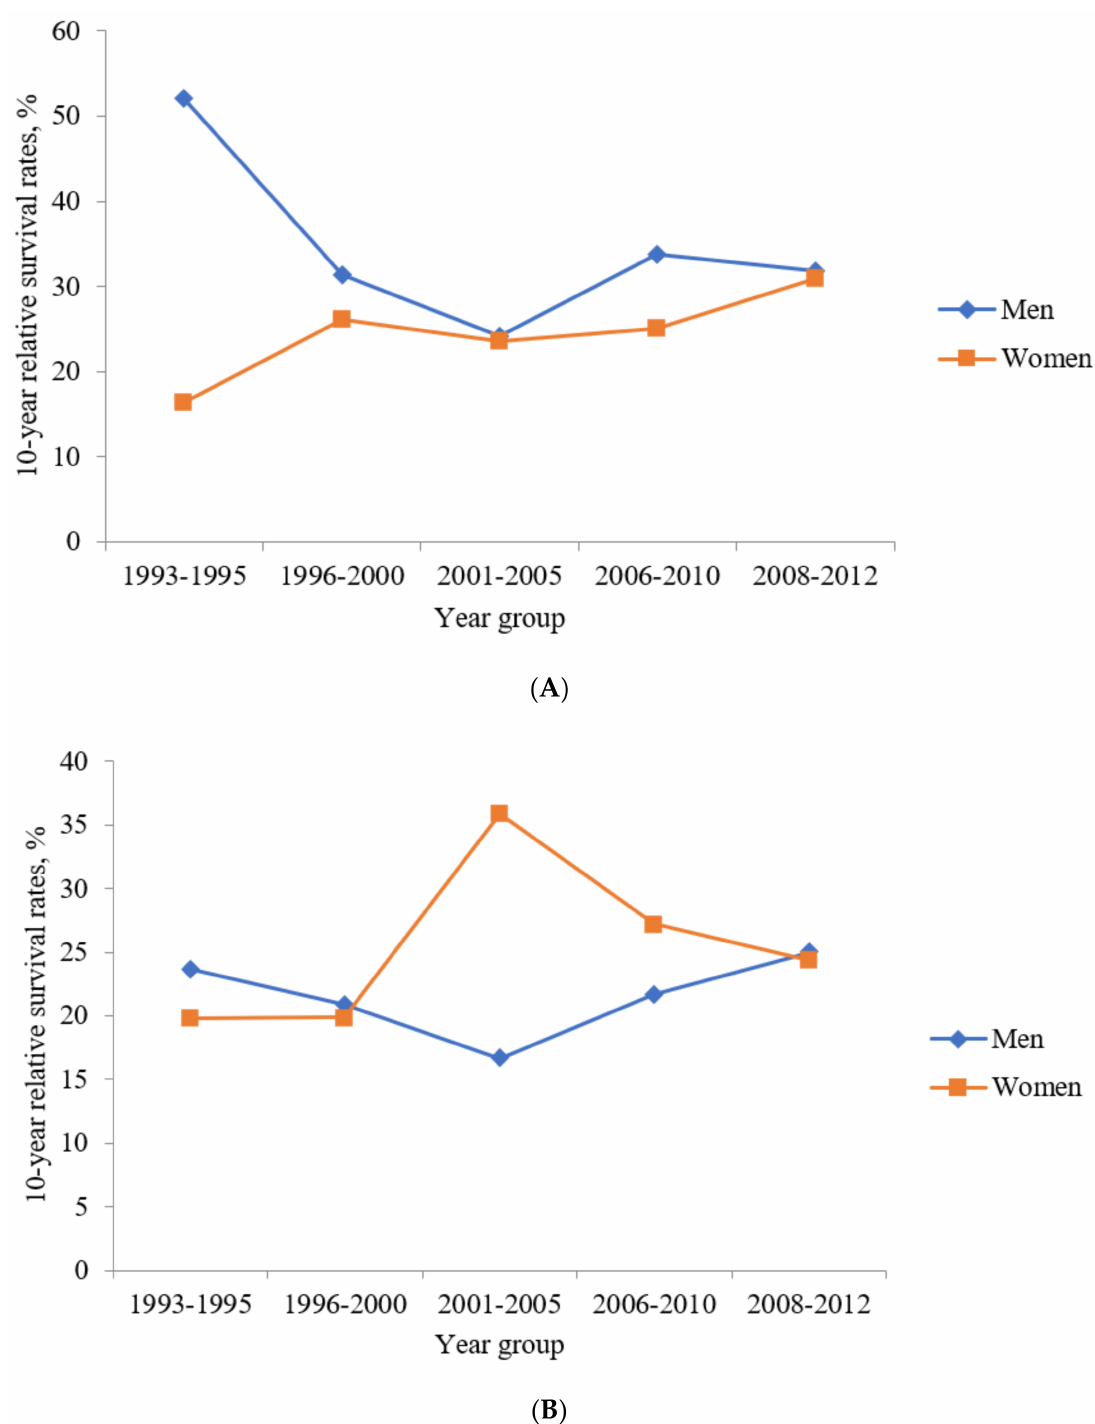
Figure 5. The ten-year relative survival rates of patients with colorectal signet-ring cell carcinoma in different time